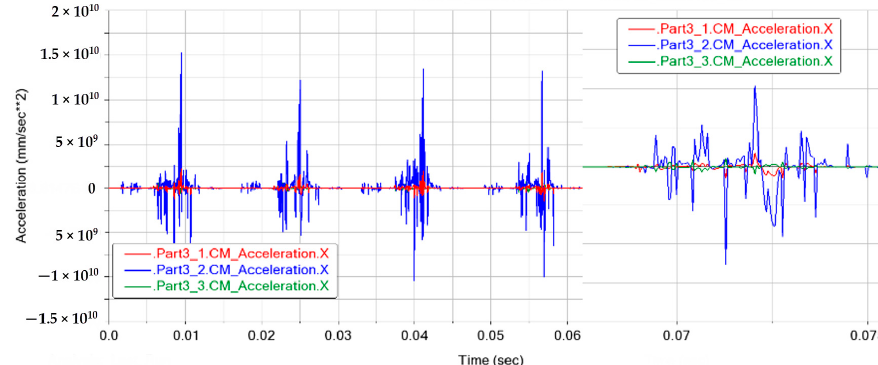
Figure 16. Engine connecting rod speed curve.